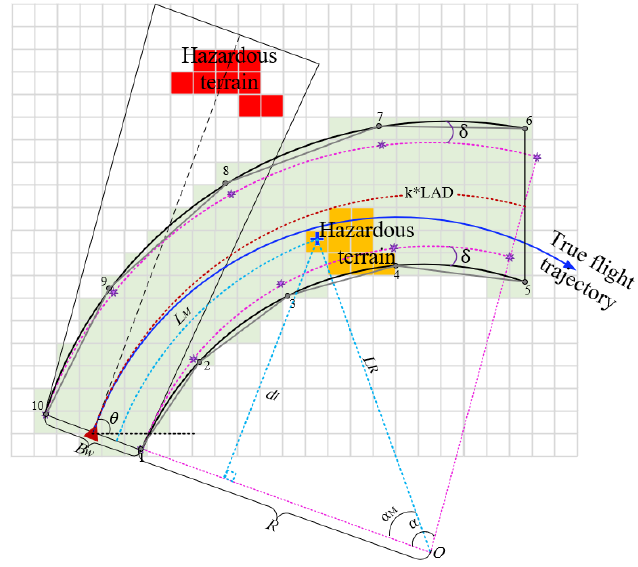
Figure 4. The pipe-shaped boundary.